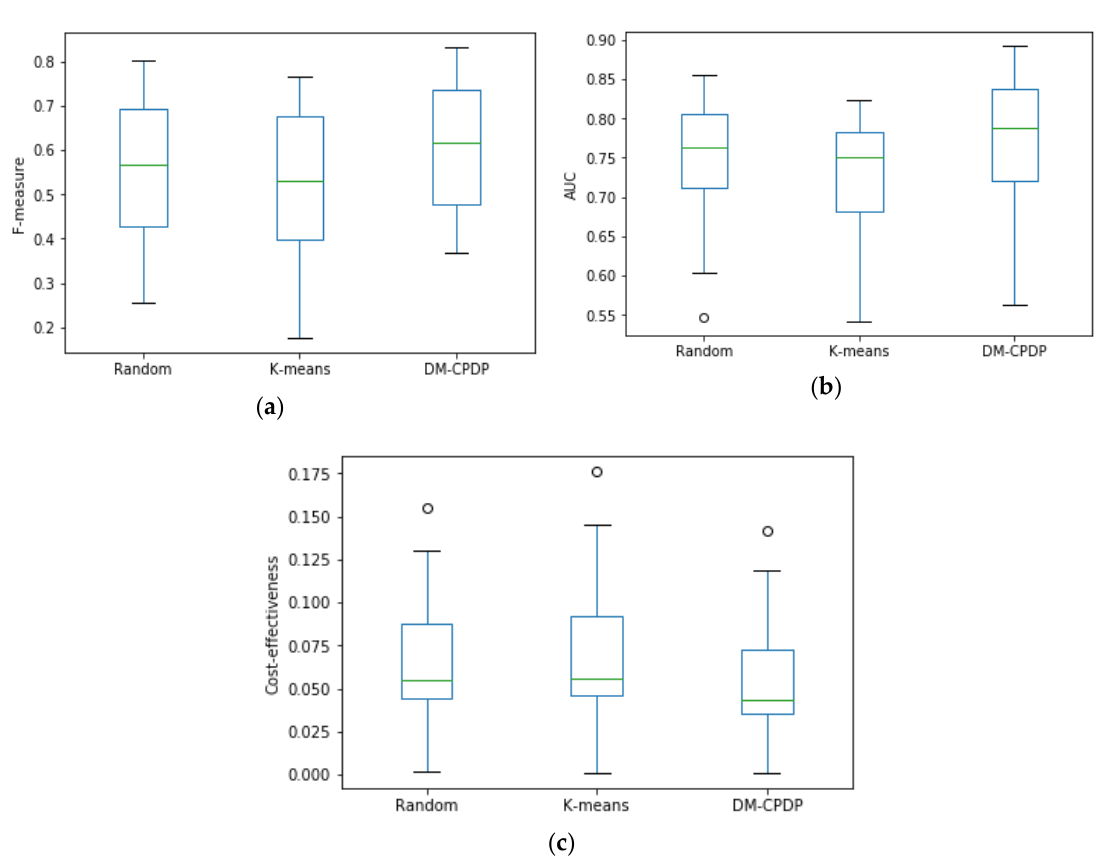
Figure 5. Box plot of different prototype selection methods. ( a ) is the situation of each method on F-measure; ( b ) is the situation of each method on AUC; ( c ) is the situation of each method on cost-effectiveness. Box plots represent maximum, upper quartile, median, lower quartile, and minimum values from top to bottom. In addition, circles represent